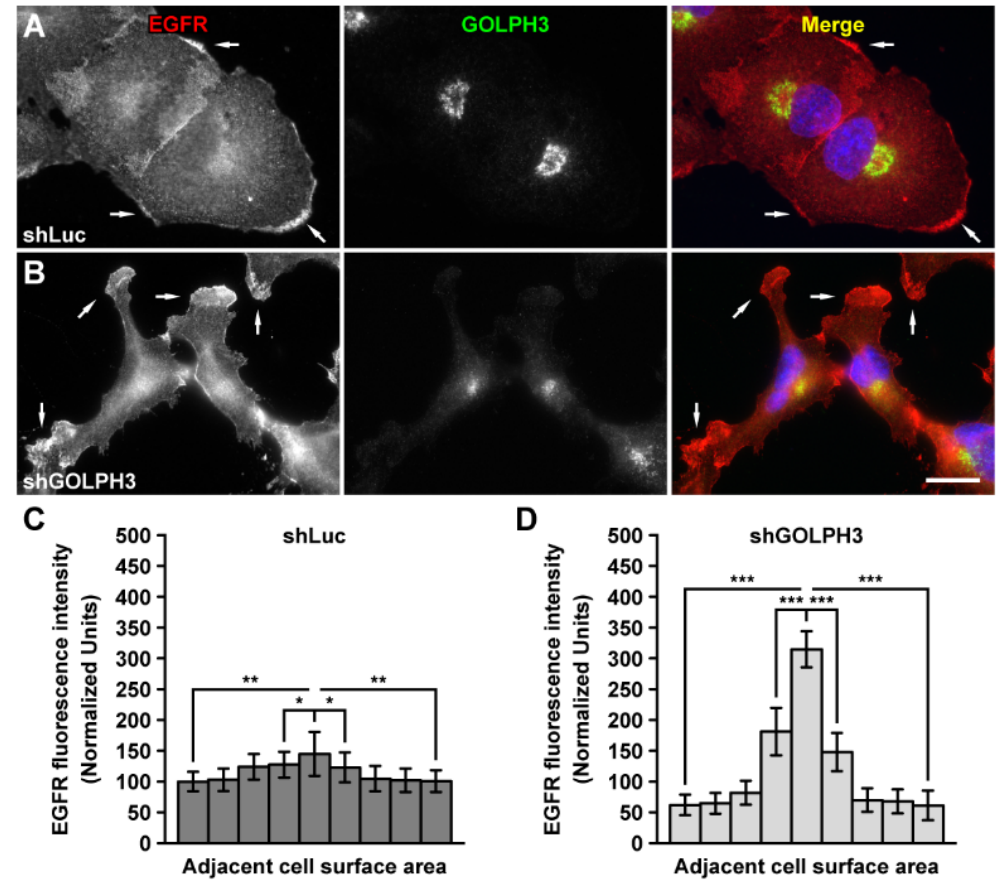
Figure 3. The knockdown of GOLPH3 promotes the concentration of EGFR at cell protrusions in T98G cells. ( A , B ) The indicated cells grown in glass coverslips were fixed, permeabilized and double-labeled with sheep polyclonal antibody to EGFR and rabbit polyclonal antibody to GOLPH3. Secondary antibodies were Alexa-594-conjugated donkey anti-sheep IgG (red channel) and Alexa-488-conjugated donkey anti-rabbit IgG (green channel), and nuclei were stained with DAPI (blue channel). Stained cells were examined by fluorescence microscopy. Merging red, green, and blue channels generated the third image on each row. Arrows indicate regions of increased concentration of EGFR at the cell surface. Bar, 10 µm. ( C , D ) Histograms of the distribution of fluorescence intensity signal in cell surface areas (5 µm 2 ) at the periphery of the indicated cells, and adjacent to an area of apparent high fluorescence intensity. The fluorescence intensity signal was normalized to that of the area with a lower level in control cells. Bars represent the mean ± standard deviation ( n = 20; * p < 0.05; ** p < 0.01; *** p < 0.001).